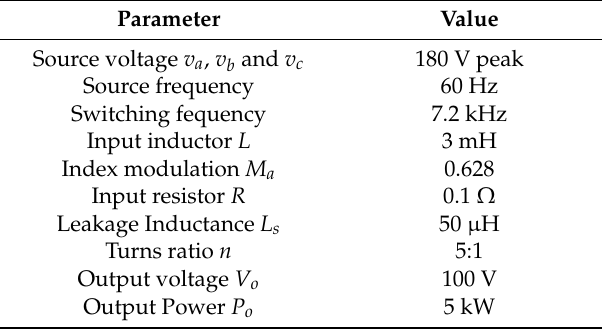
Figure 15. Variation of φ : ( a ) φ = 3°; ( b ) φ = 7°.